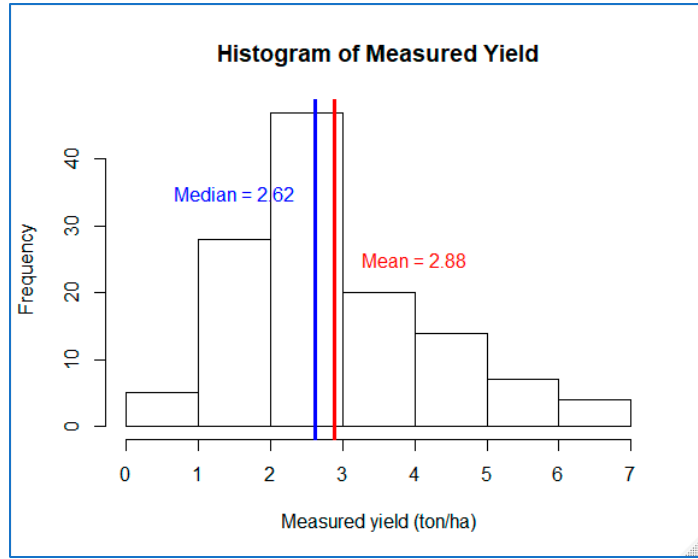
Figure 7. Histogram of measured yield with mean and median values.